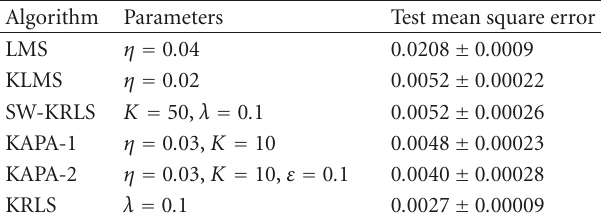
Table 4: Performance comparison in MG time series